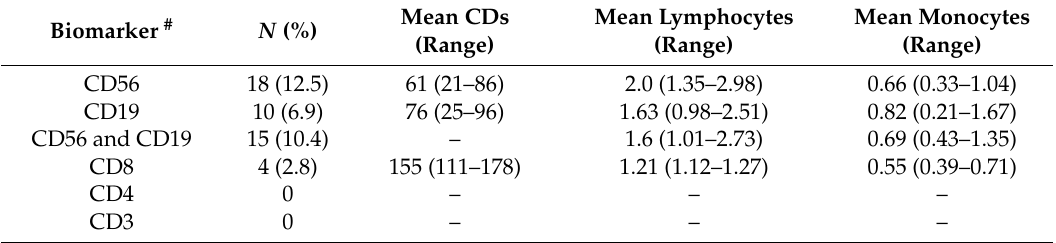
Table 4. Patients with isolated subnormal levels of CD56, CD19, CD8, and CD4, as well as both CD19 and CD56, with corresponding lymphocyte and monocyte counts in those